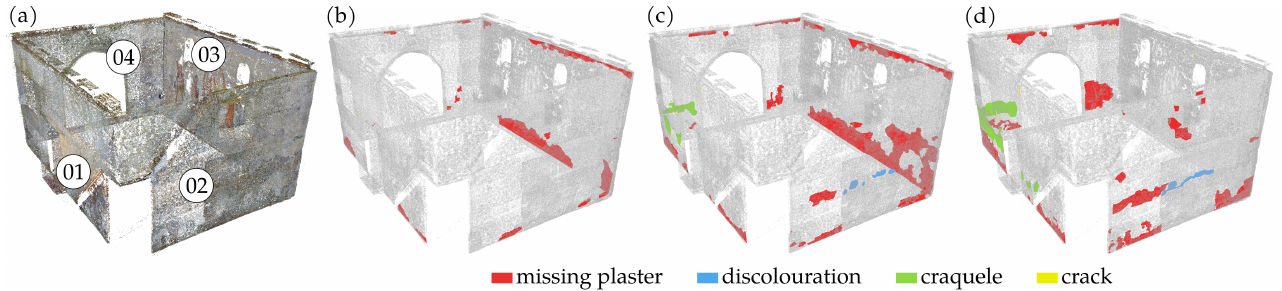
Figure 6. Three-dimensional view of ( a ) the segmented walls with assigned numbering 01–04 and ( b , c ) the mapped 3D annotations as coloured decay mapping in the states ( b ) t 1 , ( c ) t 2 , and ( d ) t 3